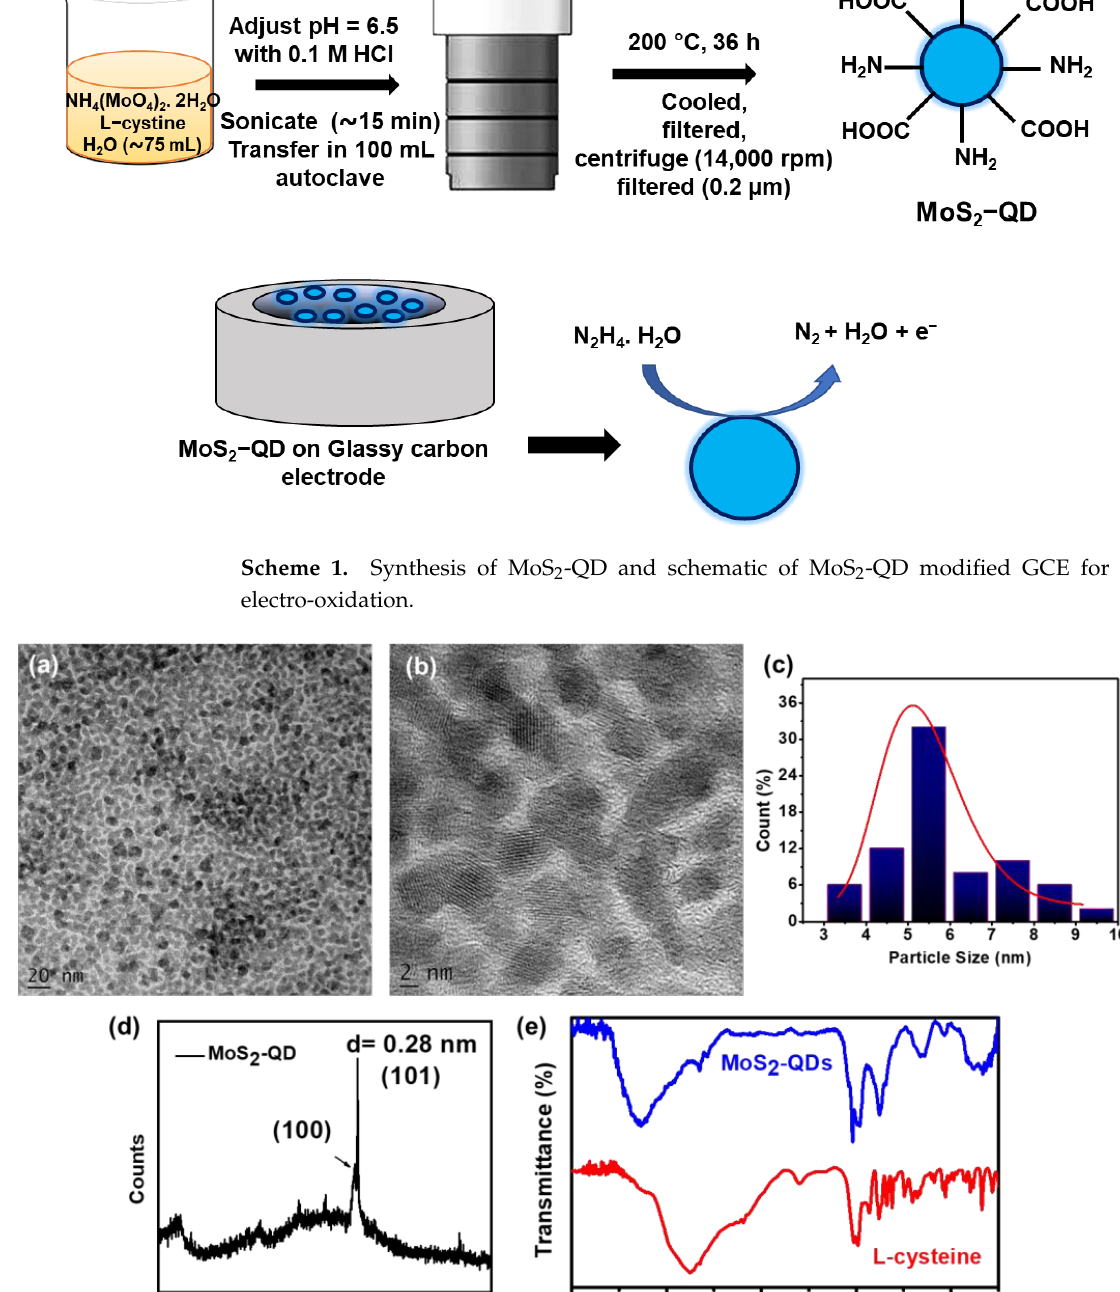
Figure 2. ( a ) SEM image of MoS 2 QDs and corresponding elemental mapping for ( b ) C, ( c ) N, ( d ) Mo, ( e ) O, and ( f ) S. ( g ) The EDX spectroscopy of the MoS 2 − QDs. The electrochemical characteristics of MoS 2 − QDs were performed by CV measure- ments using a 0.1 M PBS buffer solution having neutral pH (pH ~7.0) as electrolyte. The bare GCE and MoS 2 -QDs on GCE both revealed no oxidation peak in the absence of hy- drazine, as shown in Figure 3a. However, compared to the bare GCE, MoS 2 -QDs modified GCE exhibited an increment of ~4.5 folds higher anodic current to suggest the improved